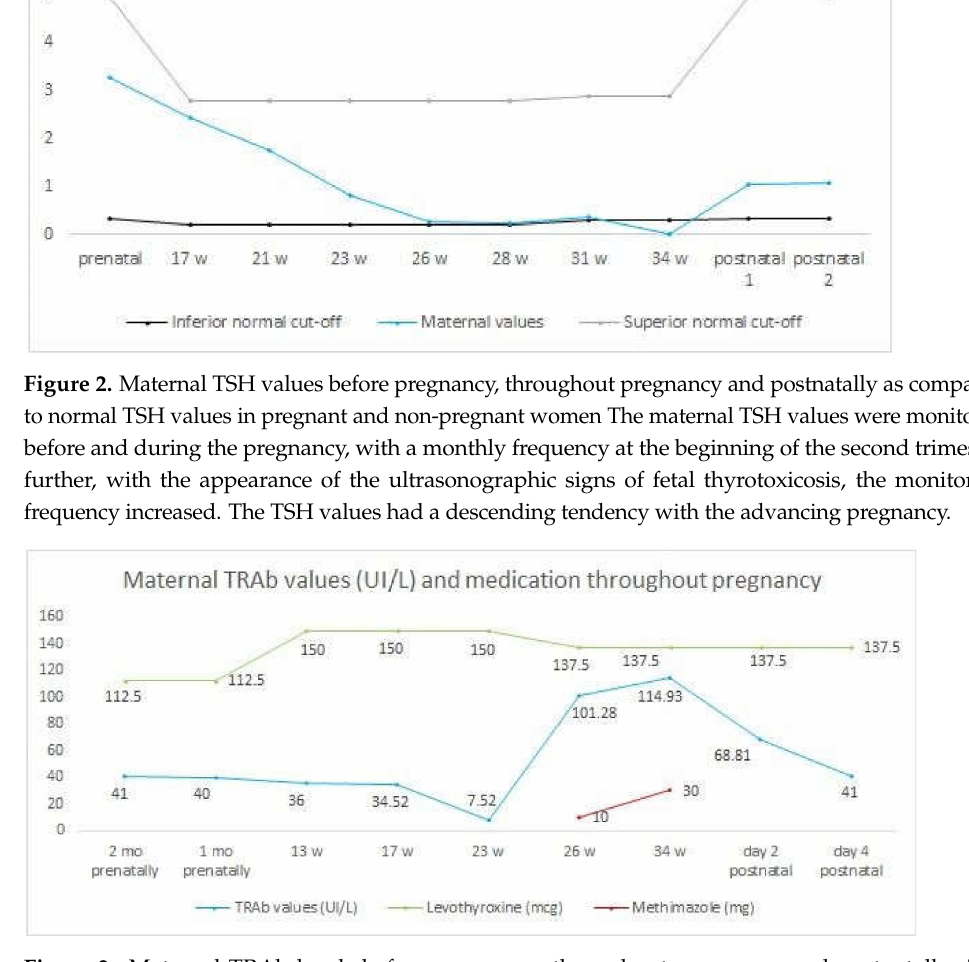
Figure 3. Maternal TRAb levels before pregnancy, throughout pregnancy and postnatally. The decrease of TRAb values in the 23rd gestational week corresponded to the appearance of fetal thyrotoxicosis ultrasonographic signs. The Levothyroxine was increased in the first trimester, with a decrease in the 23rd gestational week. Methimazole was introduced in the 26th gestational